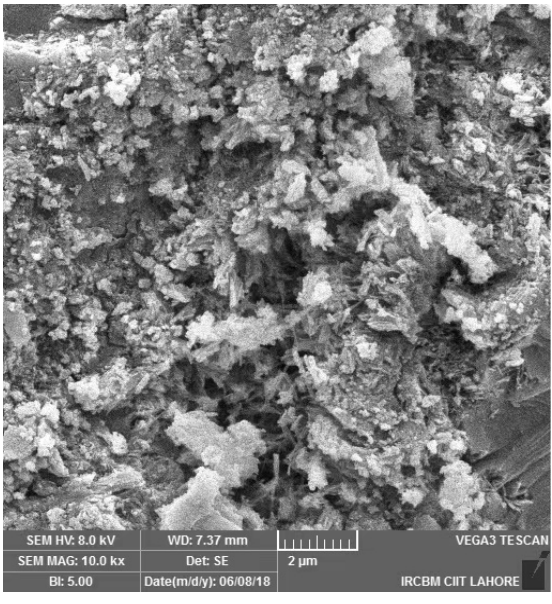
Figure 11. SEM of human hair fiber concrete incorporation silica fume.